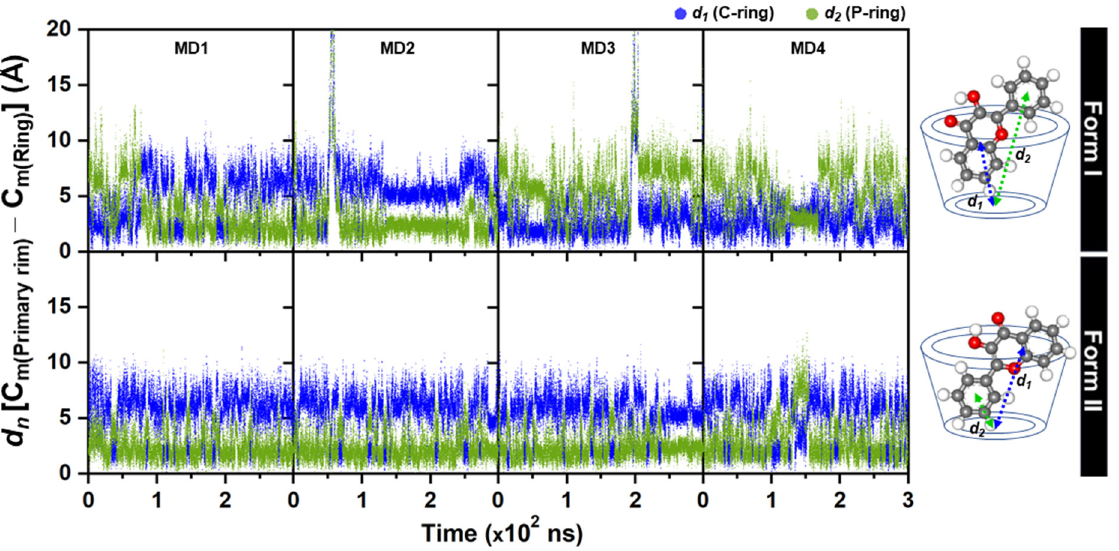
Figure 2. The plots of distance measured from the C m of each 3HF ring to the C m of the primary rim of γ -CD (all 7 O6 atoms) for the four MD simulations MD1-MD4 with different initial structures of complexes in Form I and Form II.